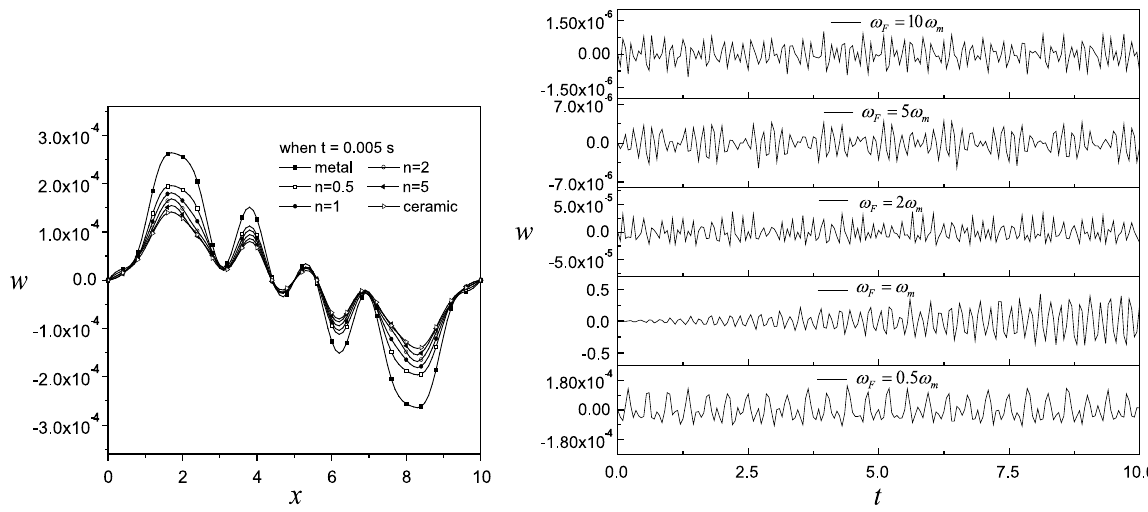
Fig. 25. Effect of the loading frequency on the mid-plane deflection of the simply supported FGPM cylindrical shell imposed by a cosine distributed load at x = 3